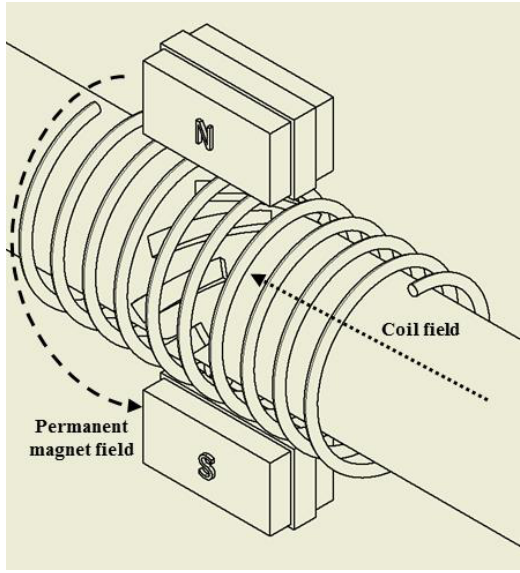
Figure 5. Magnetostrictive transducer design.